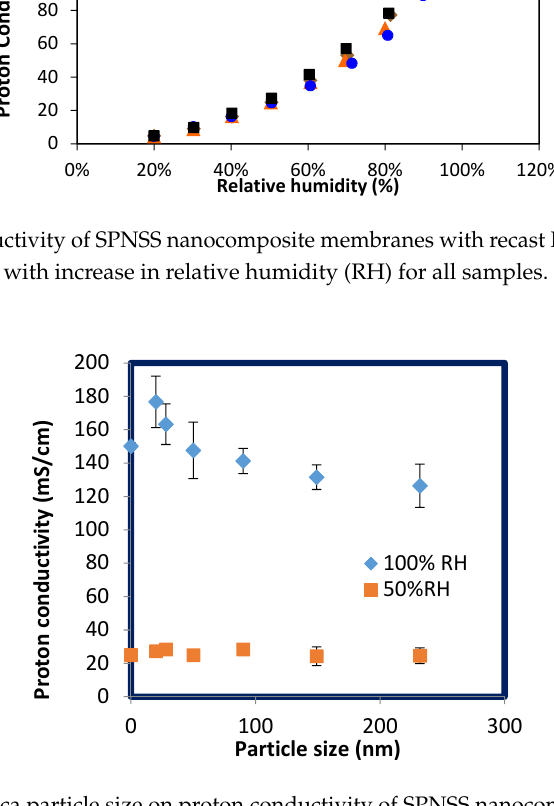
Figure 3. Impact of silica particle size on proton conductivity of SPNSS nanocomposite membranes for both 50% RH and 100% RH at 80 °C. Data at zero particle size corresponds to the data for recast Nafion.